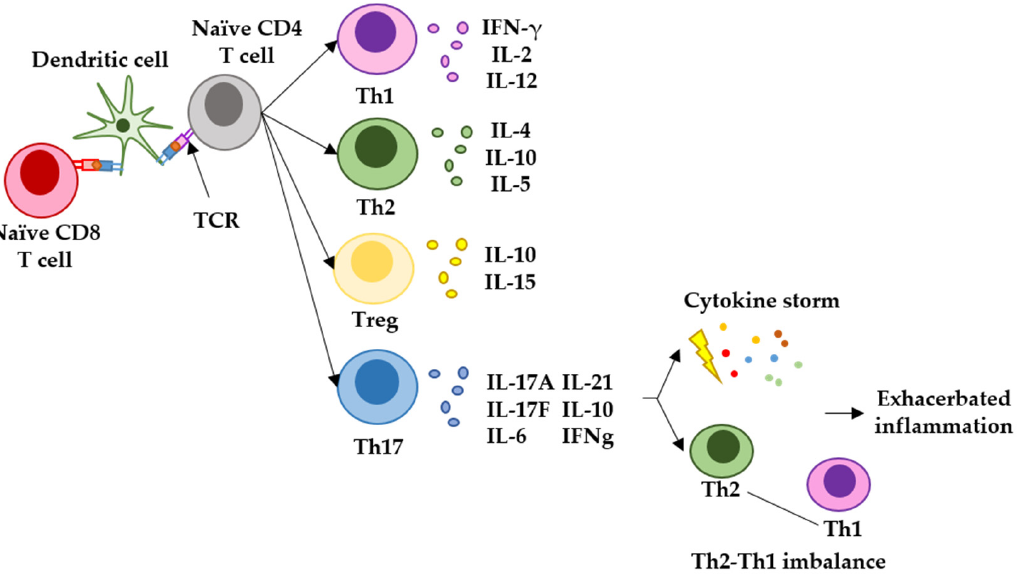
Figure 3. Representation of the main T-helper responses after antigen presentation to CD4 T cells and the role of Th17 response in generating exacerbated inflammation. Naïve CD4 and CD8 T cells recognize antigenic peptides presented by dendritic cells through the T-cell receptor (TCR). Different T-helper pathways can be activated, but the main responses observed in infectious diseases and vaccination are represented here. The Th1 response is characterized by T cells expressing IFN-gamma and IL-2, and regulate antiviral cytotoxic responses. The Th2 response is characterized by T cells expressing mainly IL-4 and IL-10, and regulated B-cell maturation to plasma cells, leading to antibody responses and airway inflammation. T-regulatory cells express mainly IL-10 and IL-15, and inhibit autoreactive damage. Finally, the Th17 response is characterized by T cells expressing mainly IL-17, IL-6, IL-21, IL-10 and IFNgamma. Th17 responses are strong inflammatory reactions caused by an immunological stress, and can lead to cytokine storms and imbalance in Th1-Th2 re-sponses.